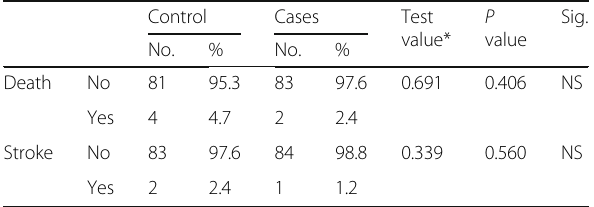
Table 6 Comparison between cases and control regarding in- hospital MACE Control Cases Test